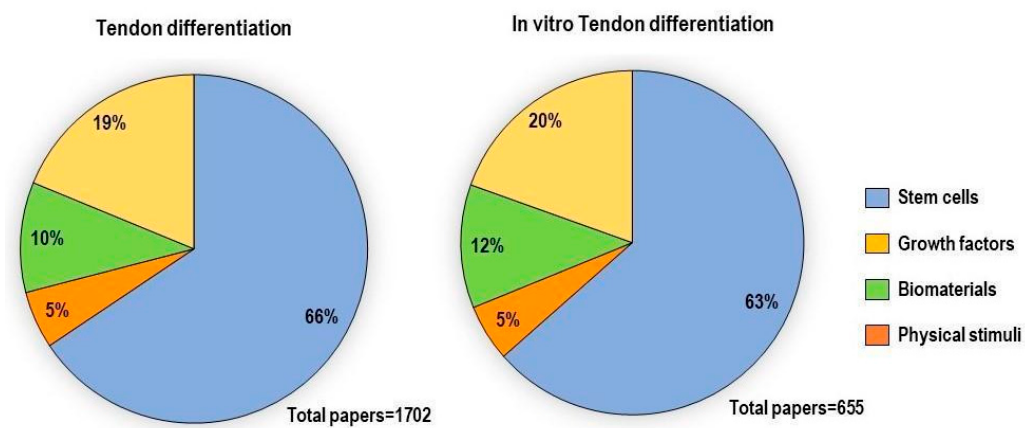
Figure 5. The comparative scientometric analysis of available publications on the Scopus database on tendon differentiation and in vitro tendon differentiation reveals four main common topics: stem cells, growth factors, biomaterials, and physical stimuli. The topic papers’ distributions amongst topics are independent of tendon differentiation sub-category (tendon or in vitro tendon differentiation). Stem cells are the most represented one (approximately 65%) followed by growth factors (approximately 20%), biomaterials (approximately 10%), and finally physical stimuli (for both